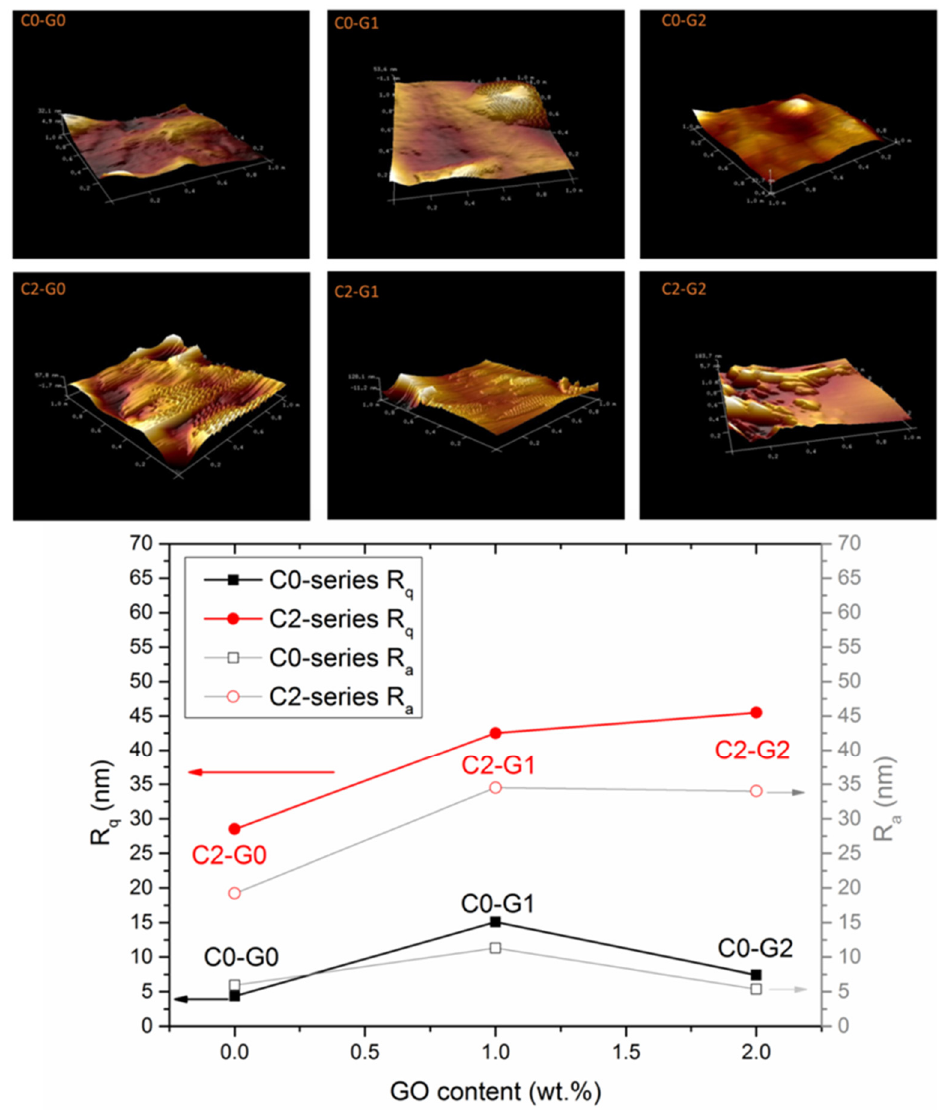
Figure 4. AFM images of the samples, together with the quadratic (left Y–axis) and arithmetic (right Y–axis) mean roughness, plotted as a function of GO content for both the C0–series and C2–series nanocomposites.